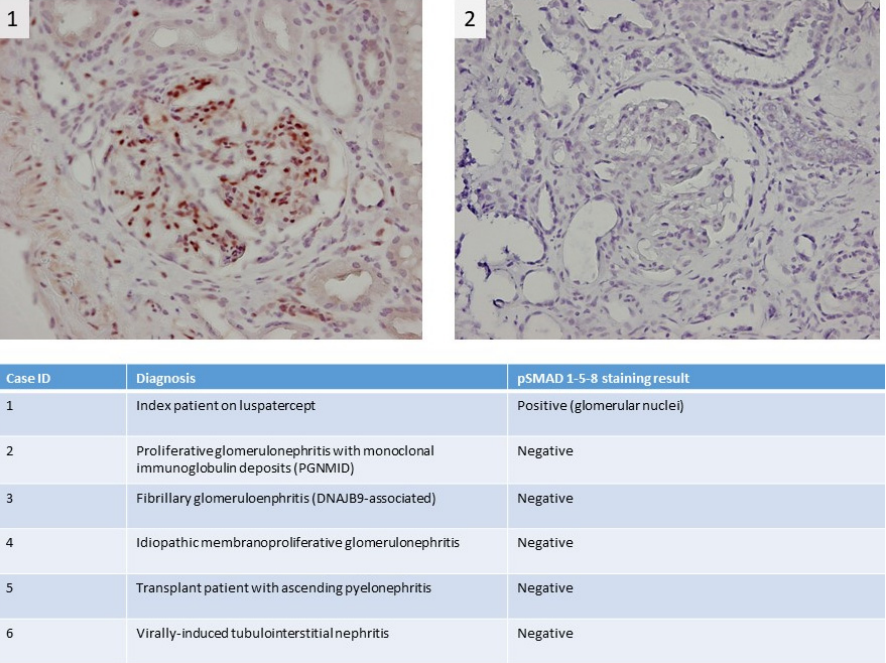
Figure 2. Immunohistochemical pSMAD 1-5-8 staining shows strong staining in the kidney of the myelodysplastic syndrome with ring sideroblasts (MDS-RS) patient; more specifically, there is clear positivity in the nuclei of the glomerular cells, which indicates activation of the pSMAD 1-5-8 pathway ( 1 ). For comparison, the staining results of a control patient with a membranoproliferative pattern due to proliferative glomerulonephritis with monoclonal immune deposits (PGNMID) are depicted in the right panel ( 2 ). In the table, staining results for pSMAD 1-5-8 in additional control patients are summarized.